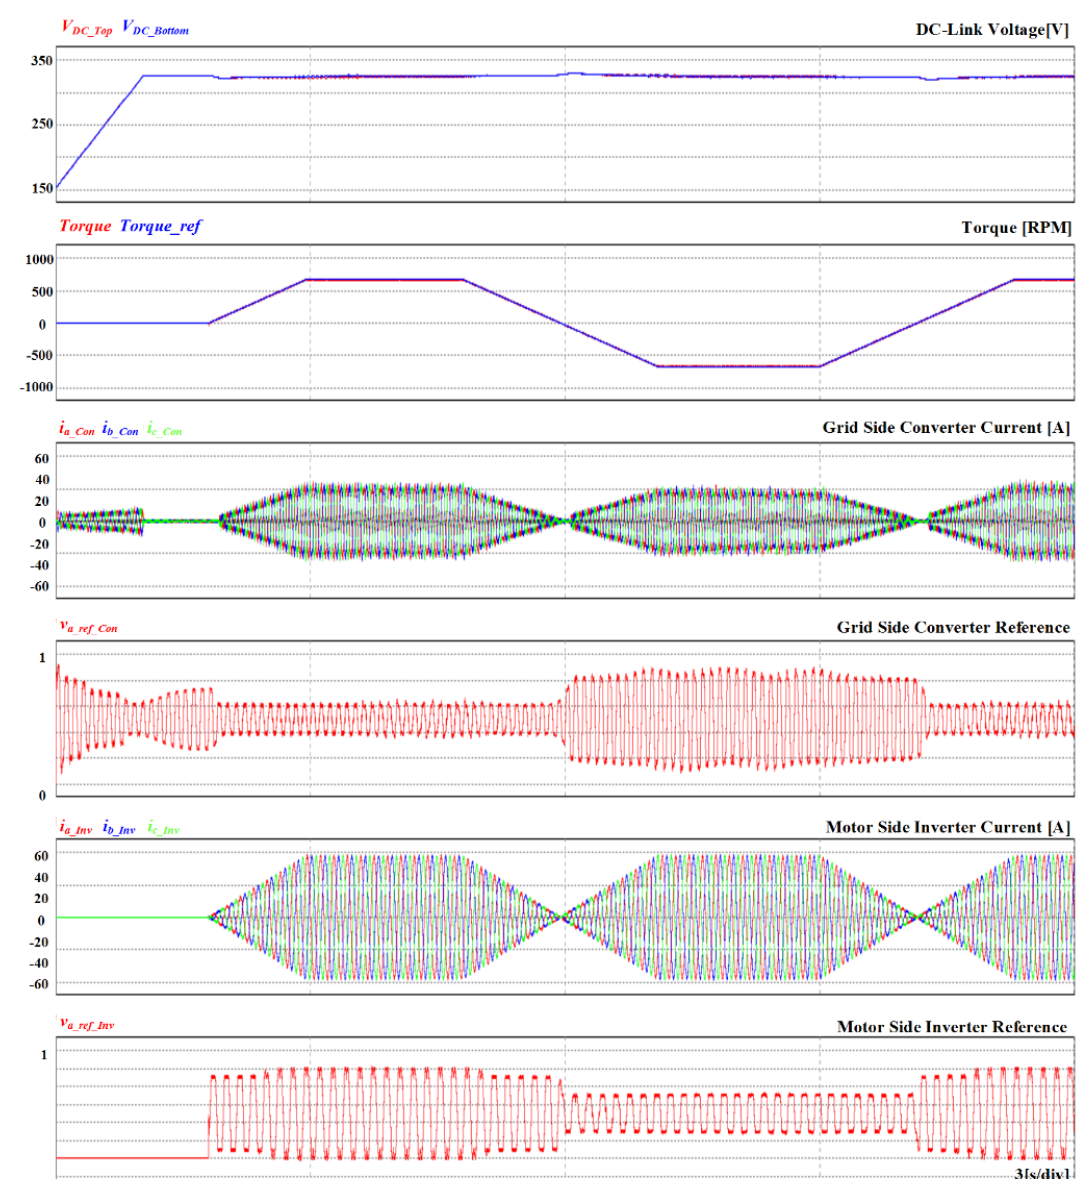
Figure 15. Simulation results of PMSG torque control using the conventional space vector pulse width modulation (SVPWM) with dead time.